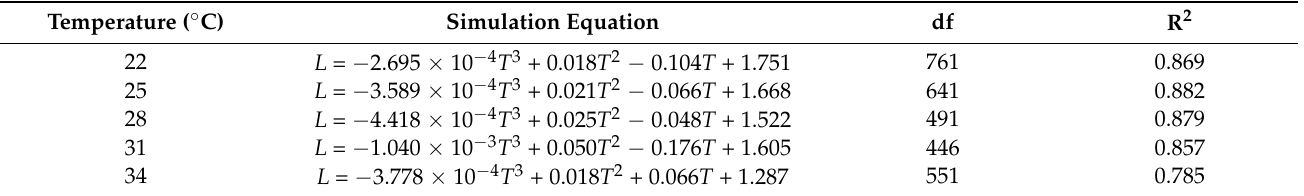
Figure 5. Larval body length of Necrobia ruficollis changes with time at five constant temperatures. Table 4. Equations, degrees of freedom (df), and coefficient of determination (R 2 ) of the relationship between time after hatching ( T ) (day) and the body length of Necrobia ruficollis larvae ( L ) (mm) at five constant temperatures.